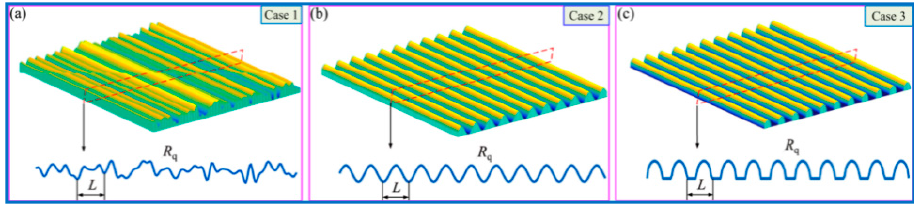
Figure 4. Three cases of CIMT configuration of MTS. ( a ) Case 1, ( b ) Case 2, ( c ) Case 3.